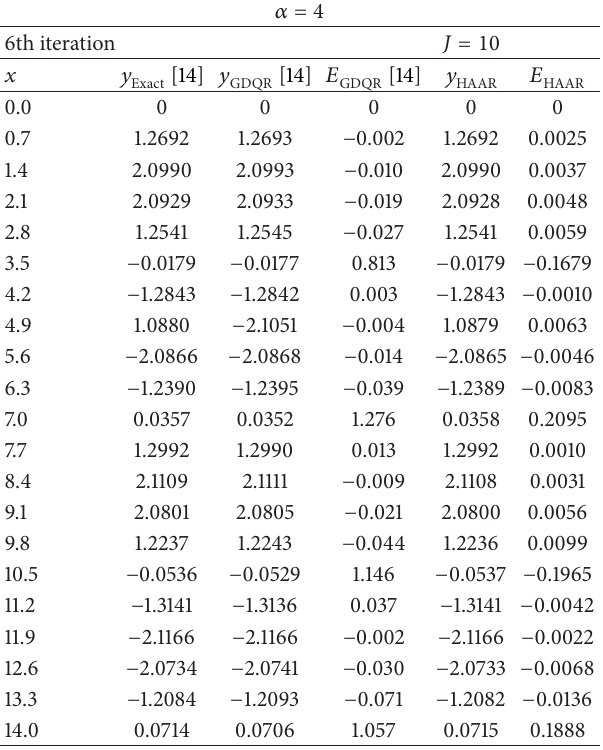
Table 5: Higher order oscillation equation: comparison of solutions by the Haar wavelet-quasilinearization technique at 6th iteration and level of resolutions 𝐽 = 10 with generalized differential quadrature rule (GDQR) method [14] and exact